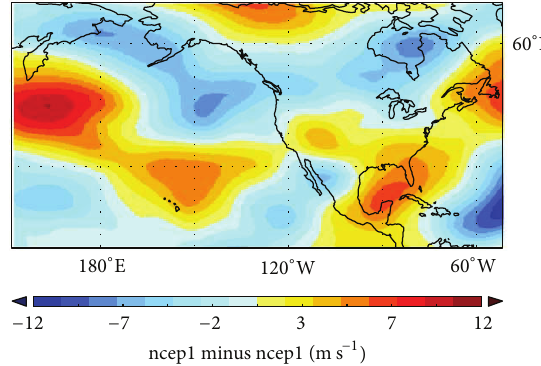
Figure 6: Averaged westerly winds in Jan 2014 minus averaged westerly winds